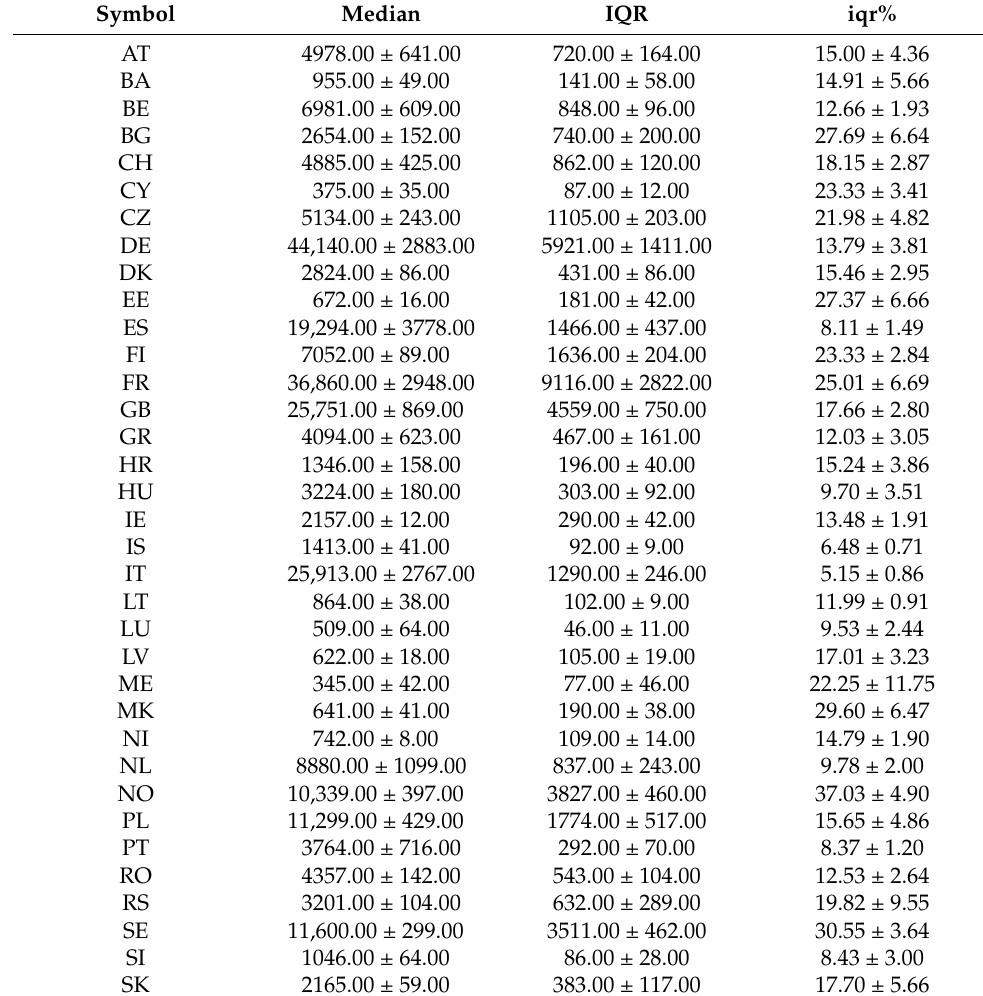
Table 1. Statistics and describing parameters analyzed MEL time